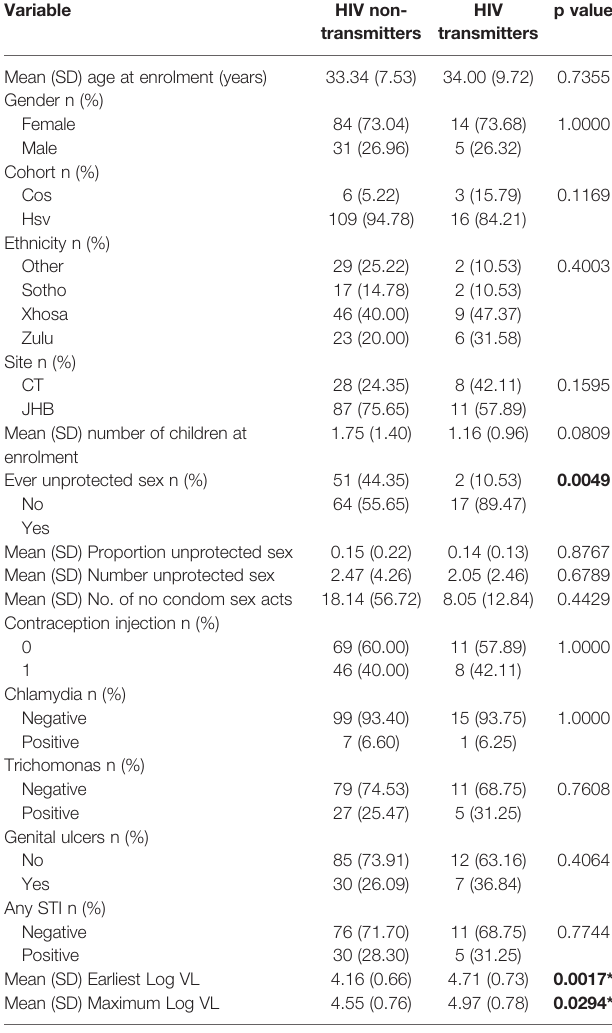
TABLE 4 | Characteristics of the index partners (partners who were HIV-infected at enrolment) (n=115 index partners to highly exposed persistently seronegative controls and 19 index partners to linked